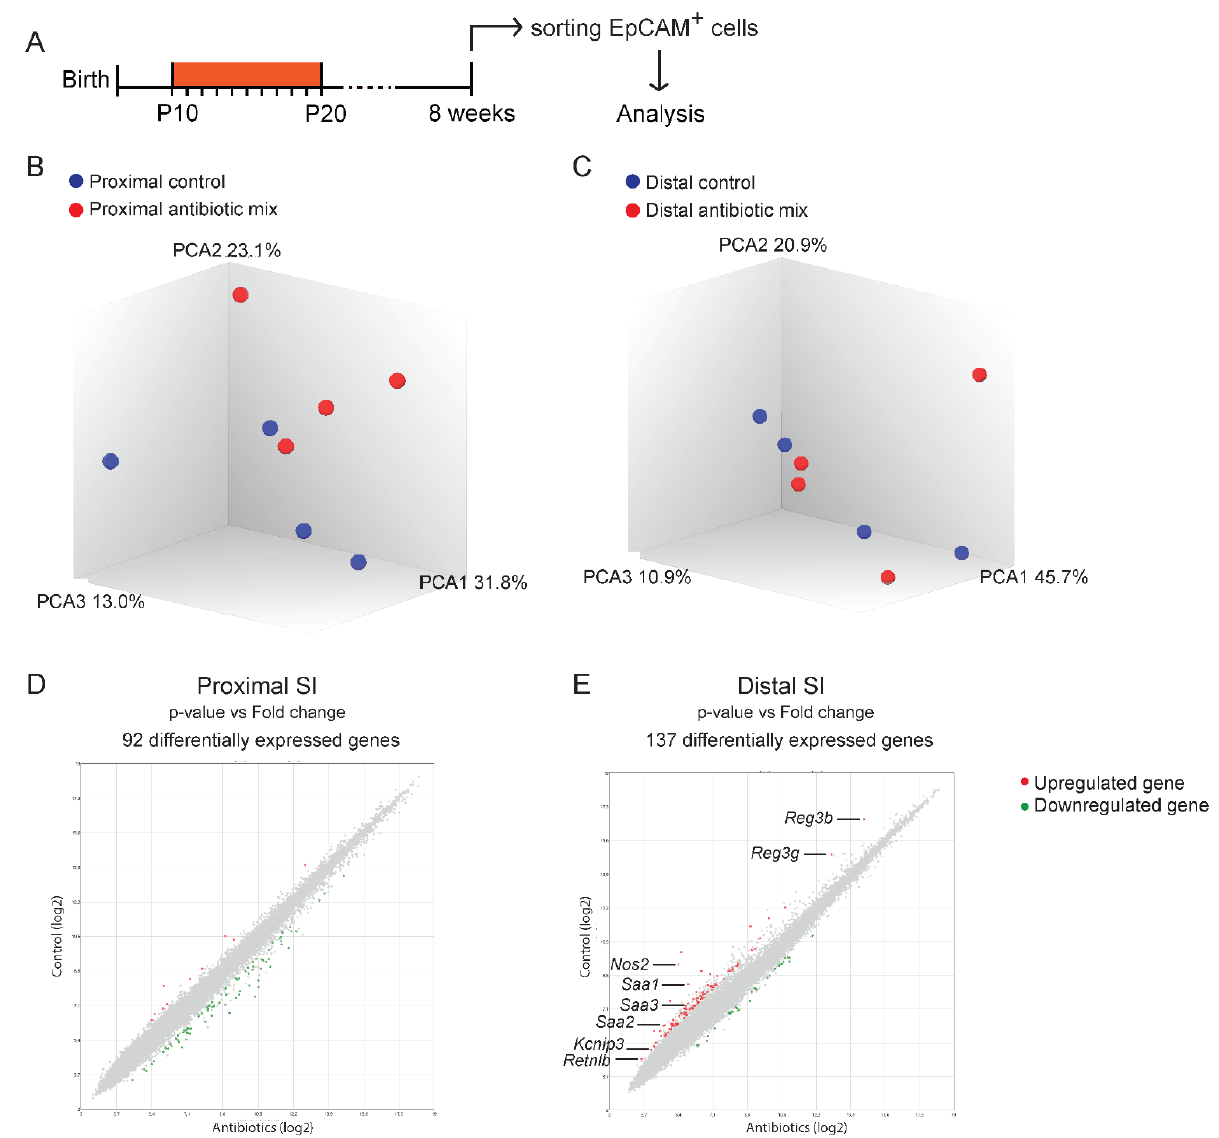
Figure 4. Genome-wide gene expression analysis of sorted intestinal epithelial cells. ( A ) Experimental design of genome-wide gene expression analysis of FACS-sorted intestinal epithelial cells of 8-week-old mice. ( B , C ) PCA analysis of sorted epithelial cells from 8-week-old proximal ( B ) and distal ( C ) small intestine treated with the antibiotic mix or PBS (control) in early life. ( D , E ) Volcano plots of microarray analysis showing genes differentially expressed between control and antibiotic-treated FACS-sorted intestinal epithelial cells of proximal ( D ) and distal ( E ) small intestine of 8-week-old mice. Green dots identify downregulated genes and red dots identify upregulated genes. Statistical analysis by ANOVA eBayes, p < 0.05 cut-off, n = 4 samples per group.